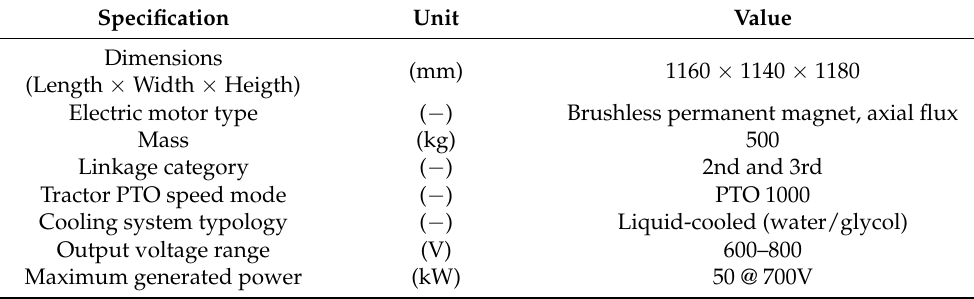
Table 2. Main e-Source specifications.